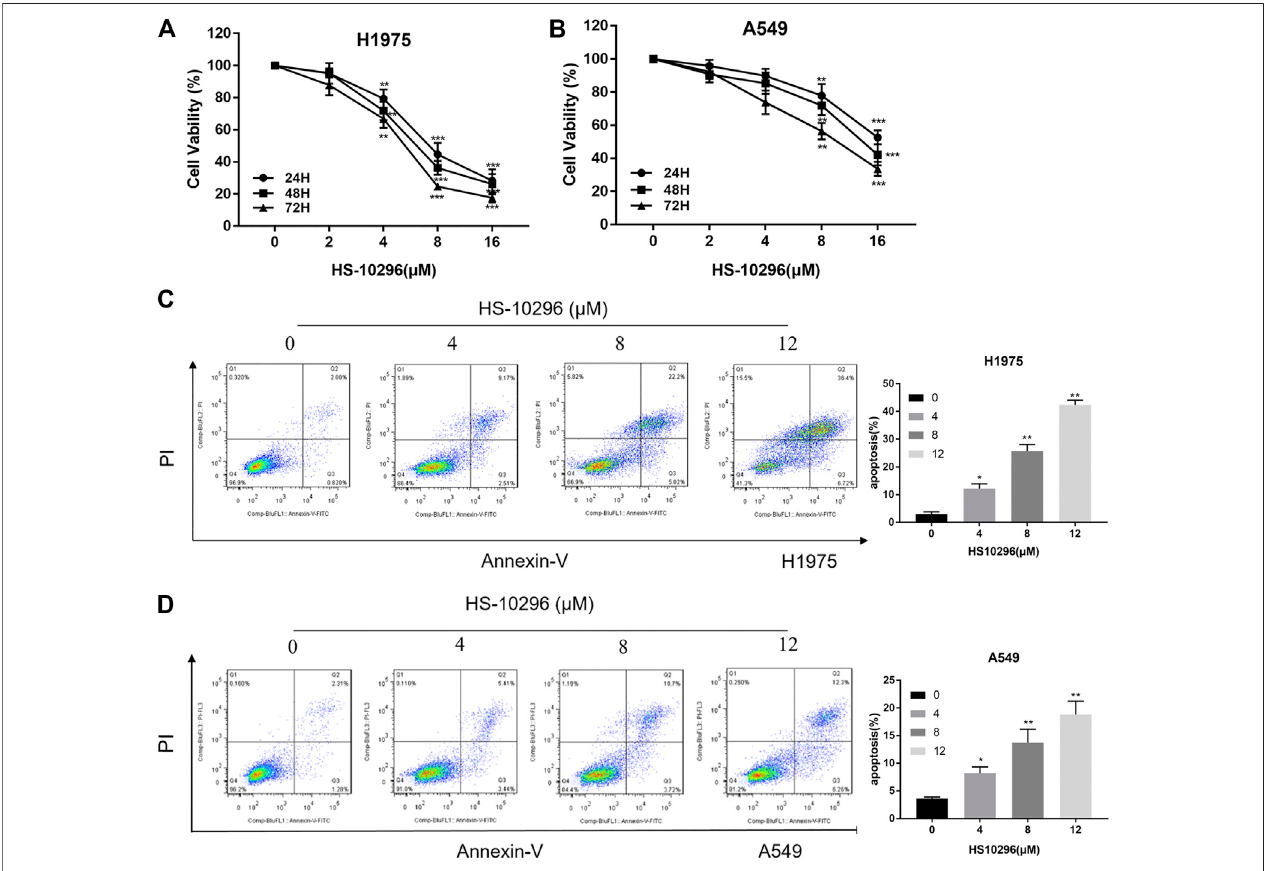
FIGURE 1 | Effects of Almonertinib on the proliferation and apoptosis of NSCLC cells. (A,B) CCK8 assay was used to detect different concentrations of Almonertinib(2,4,8,and16 µM)onH1975andA549cellsfor24,48,and72 h. (C,D) Flowcytometrywasusedtodetecttheapoptosisrateofdifferentconcentrationsof Almonertinib on H1975 and A549 cells after 24 h. Signi fi cance: * p < 0.05, ** p < 0.01,*** p <